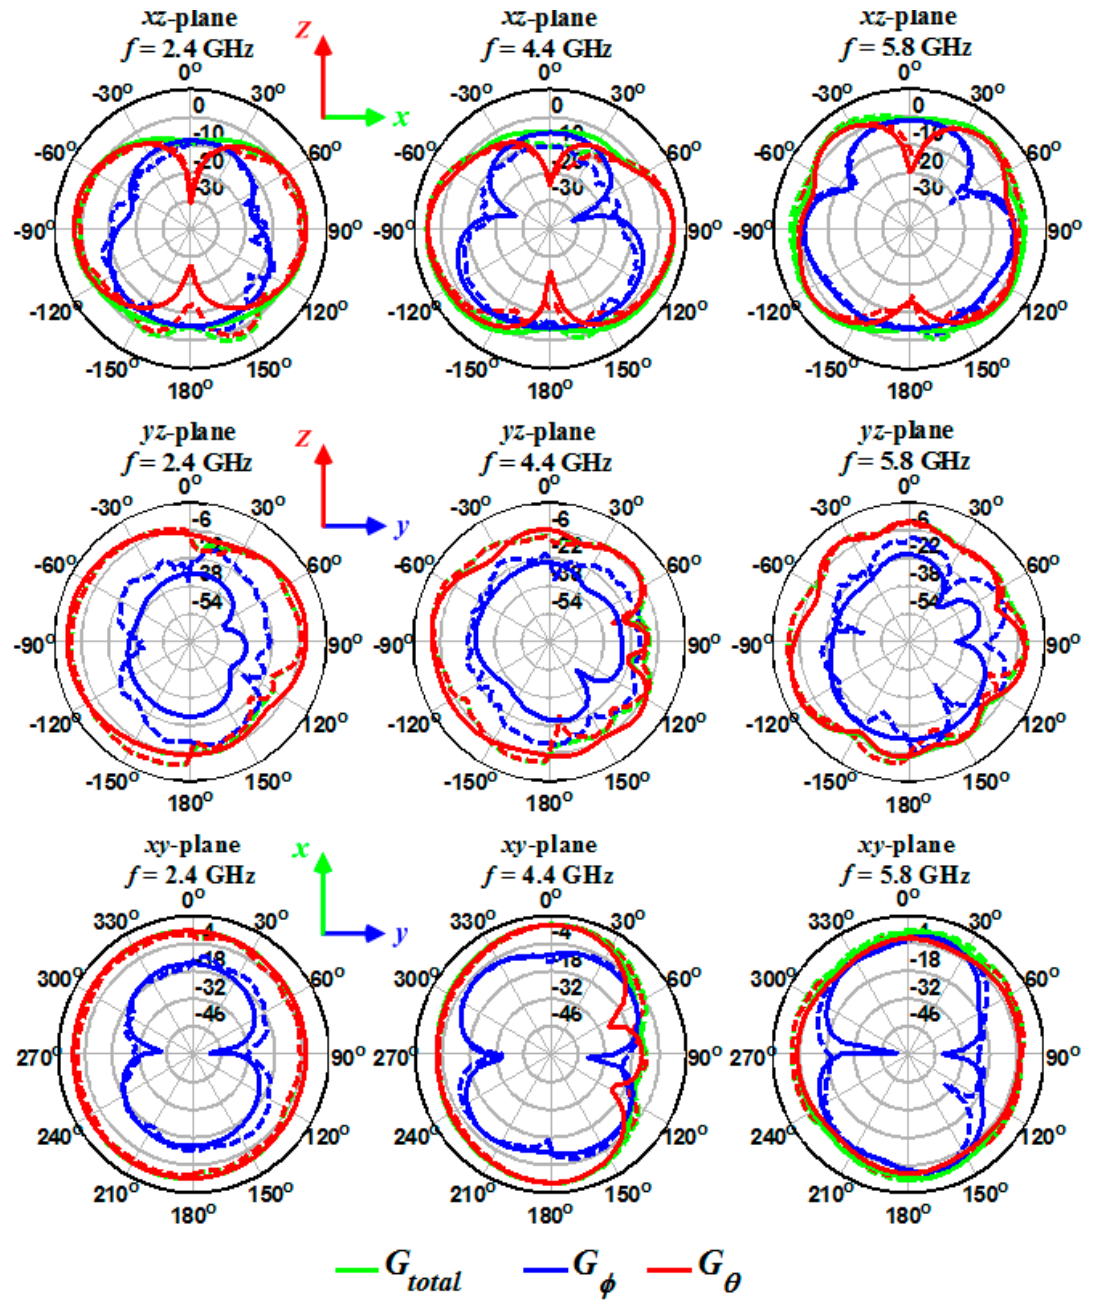
Figure 20. Measured (dashed lines) and simulated (solid lines) gain for the two-port antenna on three different planes and frequencies.